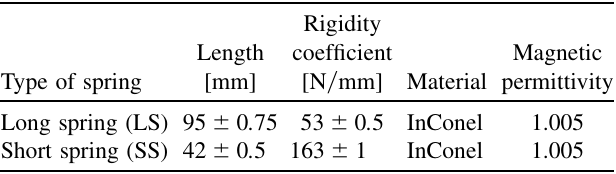
TABLE V. Characteristics of the springs.